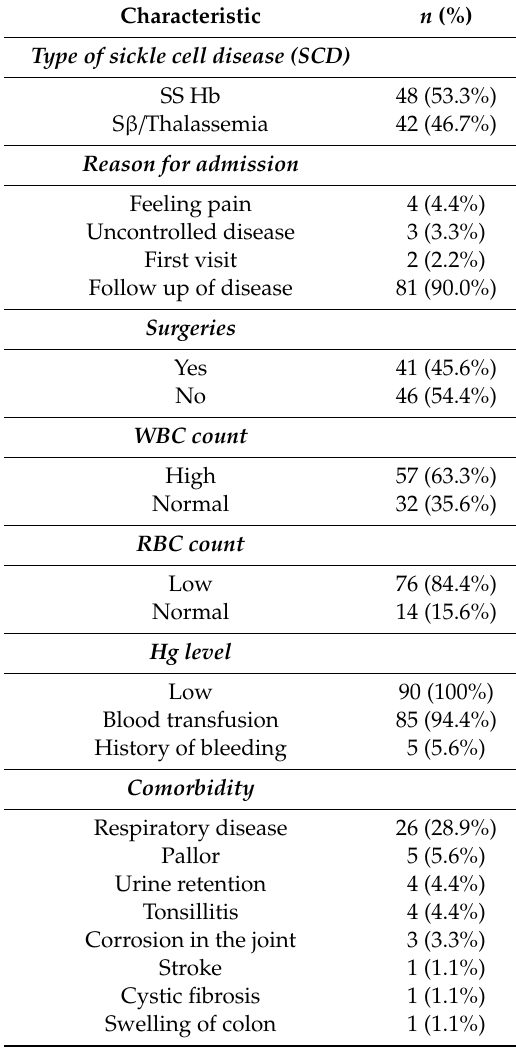
Table 2. Disease